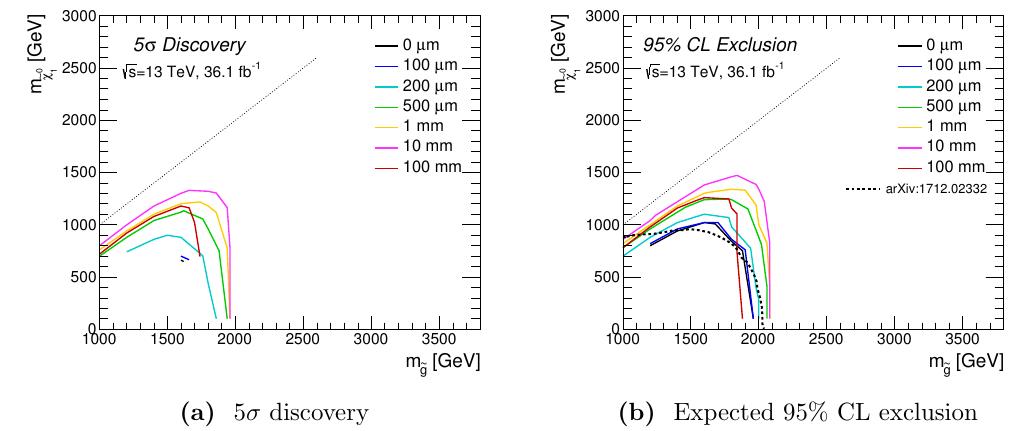
Figure 11. 5 (cid:27) discovery reaches and expected 95% CL exclusion limits for gluinos with di(cid:11)erent c(cid:28) ~ g , for an integrated luminosity of 36 : 1 fb (cid:0) 1 . The expected 95% CL exclusion limit from the ATLAS promptly-decaying gluino search [144] is also shown in the black dotted line.